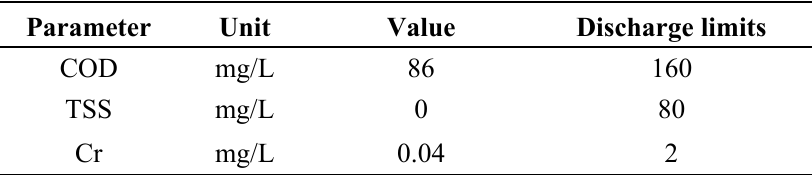
Table 5. Characteristics of the RO